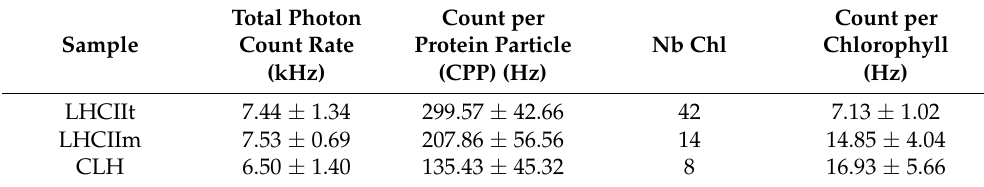
Table 2. Fluorescence properties of the antennas as determined based on ACFs obtained by FCS. Parameters: Total Photon Count Rate (kHz); Count of photons per antenna particle and per second (Count per Particle, Hz), calculated as the total fluorescence count divided by the number of particles in Table 1; The proposed number of chlorophylls (Nb Chl) per antenna particle based on literature (see Introduction); Count of photons per chlorophyll per second (Hz). Results are the average and standard deviation of 7 independent measurements. Count per Count per Total Photon Protein Particle Nb Chl Chlorophyll Sample Count Rate (CPP) (Hz) (Hz) (kHz)